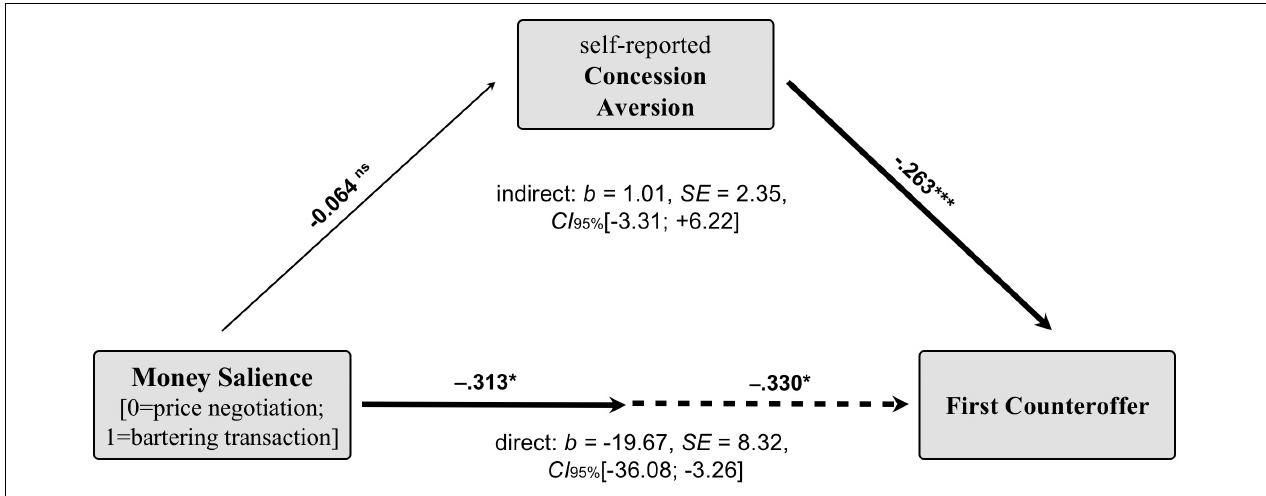
FIGURE 2 | Mediation analysis: the direct effect of money salience on first counteroffer was significant, the indirect effect through participants’ concession aversion was not due to a non-significant a-path. Path coefficients are unstandardized regression weights for Z -scored mediator and dependent variable.